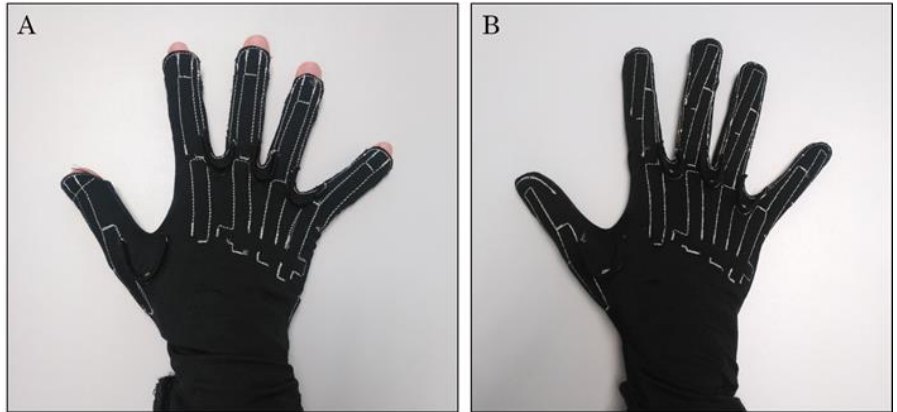
Figure 2. CyberGlove models: ( A ) 18 DoF model and ( B ) 22 DoF model. The fingertips of the 18 DoF model are not covered, allowing tactile feedback during object manipulation. Contrarily, the fingertips of the 22 DoF model are covered so